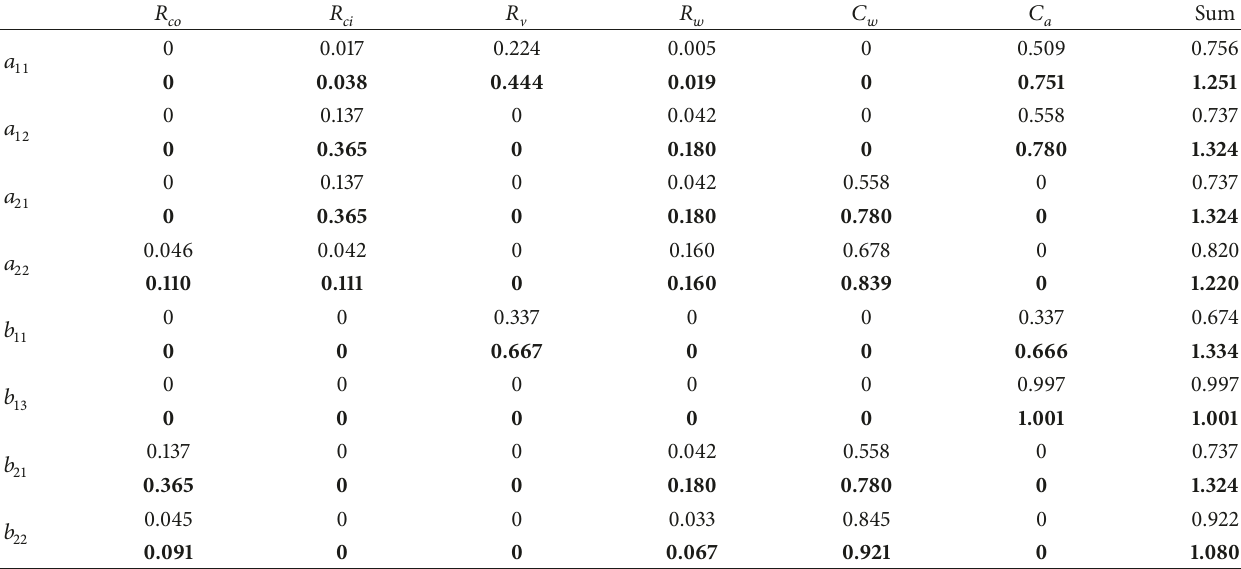
Table 7: First-order and total sensitivity indices, RC to SS transformation.